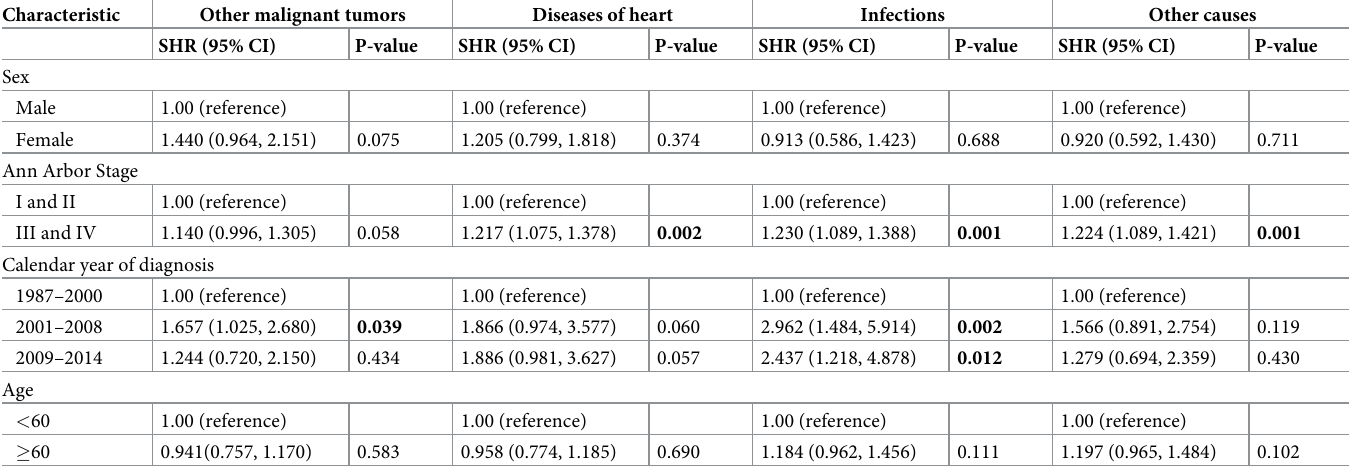
Table 6. Sub-hazard ratios with 95% confidence intervals of other causes rather than non-Hodgkin’s lymphoma by sex, Ann Arbor Stage, calendar year of diagnosis and age at diagnosis by competing-risks regression. Characteristic